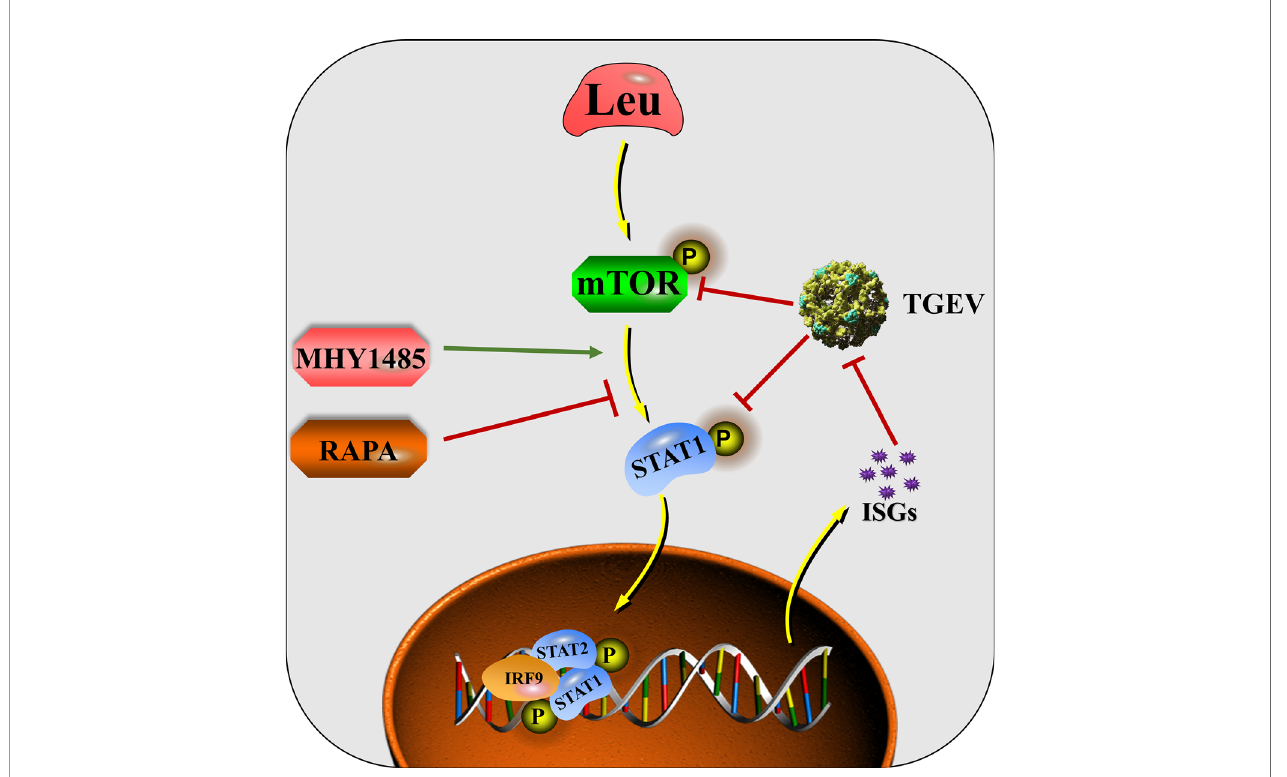
FIGURE 9 | The mechanisms by which Leu affects TGEV infection through regulating mTOR signaling in IPEC-J2